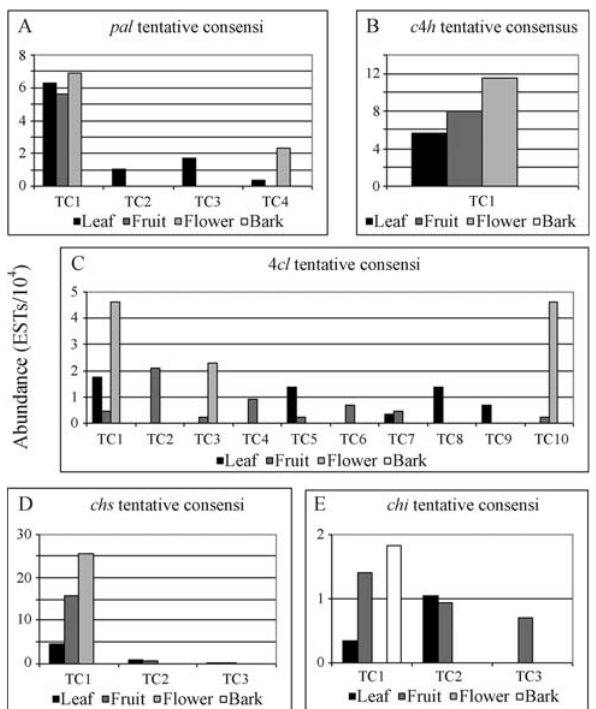
Figure 1 - Transformed data representing the relative abundance of EST reads by tissue expressed in 10 4 reads: (A) Phenylalanine ammonia-lyase (PAL), (B) Cinnamate 4-hydroxylase (C4H), (C) 4-Coumarate CoA ligase (4CL), (D) Chalcone synthase (CHS) and (E) Chalcone isomerase